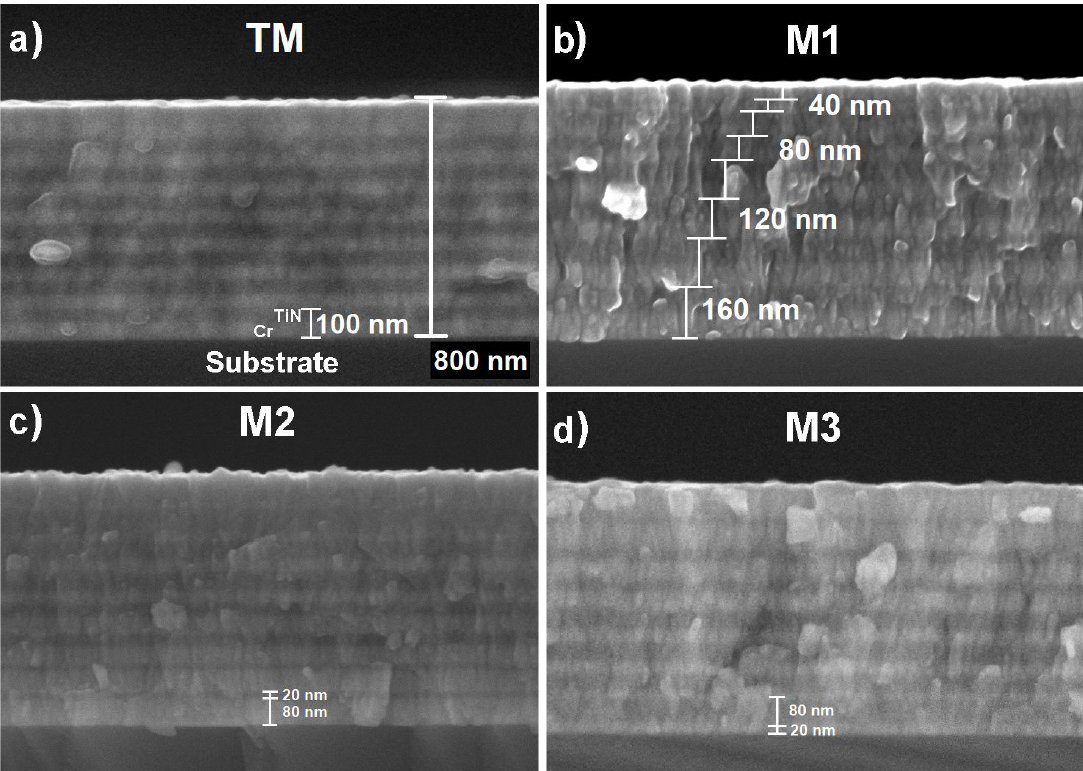
Figure 3. Micrographs of multilayers cross-sections (a) TM, (b) M1, (c) M2 and (d) M3 with magnification of